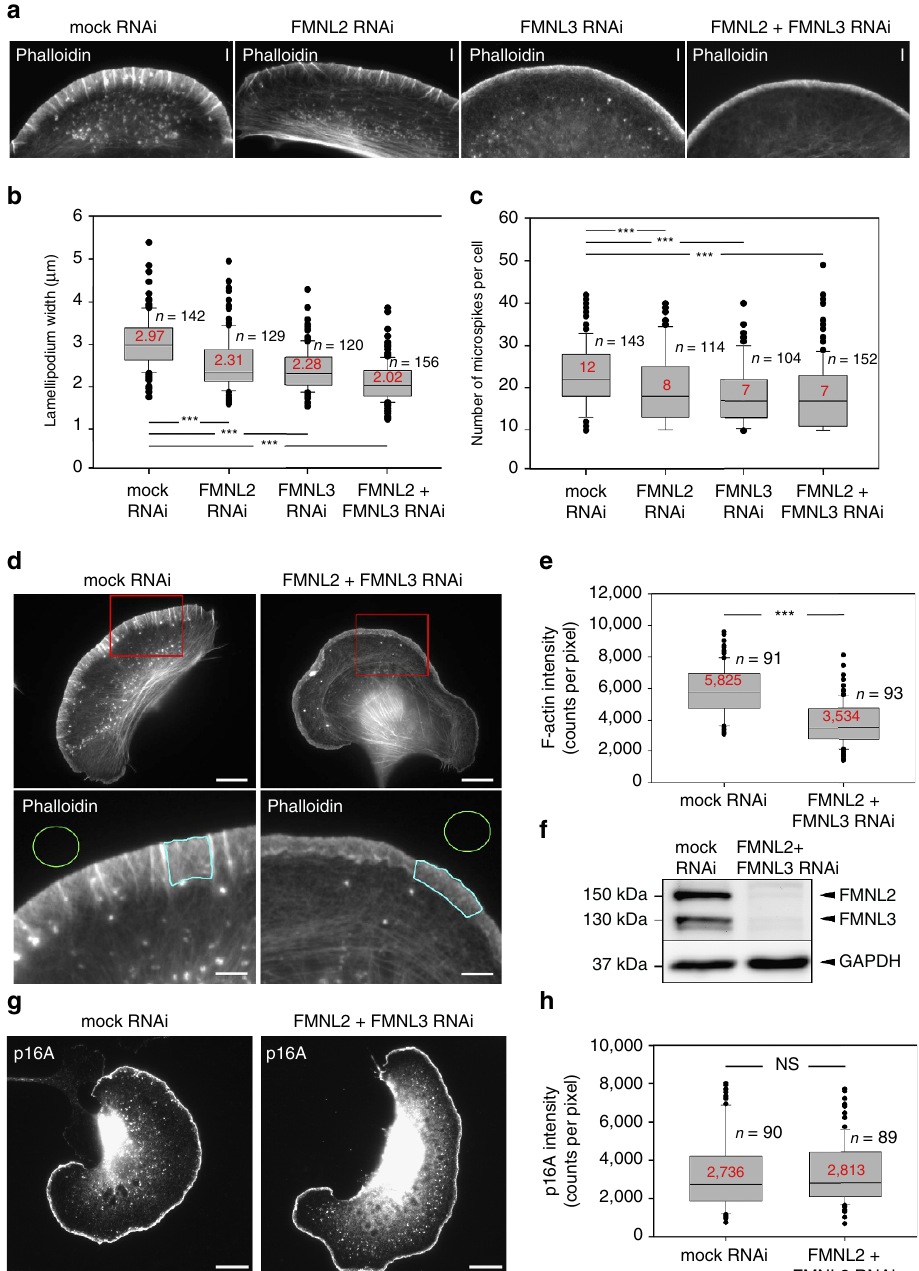
Figure 3 | RNAi-mediated knockdown of FMNL2 and -3 reduces lamellipodium width, microspike number and F-actin intensity. ( a ) Representative examples of lamellipodia from mock, FMNL2, FMNL3 or FMNL2 þ FMNL3 RNAi-treated B16 cells fixed and phalloidin-stained during migration on laminin. Bars, 3 m m. ( b , c , e ) Quantification of lamellipodium width ( m m), microspike number and F-actin intensity in lamellipodia (photon counts pixel (cid:2) 1 after background subtraction) in cells treated as in a . Results are displayed as box and whiskers plots with median values given in red, boxes including 50% (25–75%) and whiskers 80% (10–90%) of all measurements; outliers are shown as dots. n , number of cells analysed. ( d ) Examples of phalloidin-stained B16 cells RNAi-treated as indicated, and employed for quantification of F-actin intensity. Red rectangles in top panels indicate magnified insets shown at the bottom. Areas framed in turquoise depict representative regions within lamellipodia used to measure F-actin intensities, and green circles extracellular regions defined as background. Scale bars in upper and lower panels equal 10 and 3 m m, respectively. ( f ) Representative western blot illustrating RNAi-mediated knockdown efficiency from samples collected in parallel to cells used in b , c , e . ( g ) Immunolabelling of the Arp2/3 complex subunit p16A (ARPC5A) in RNAi-treated cells as indicated. Bars, 5 m m. ( h ) Quantification of Arp2/3 complex intensities in lamellipodia of mock- and FMNL knockdown cells, displayed as described in b , c , e . *** p o 0.001 by Mann–Whitney rank sum